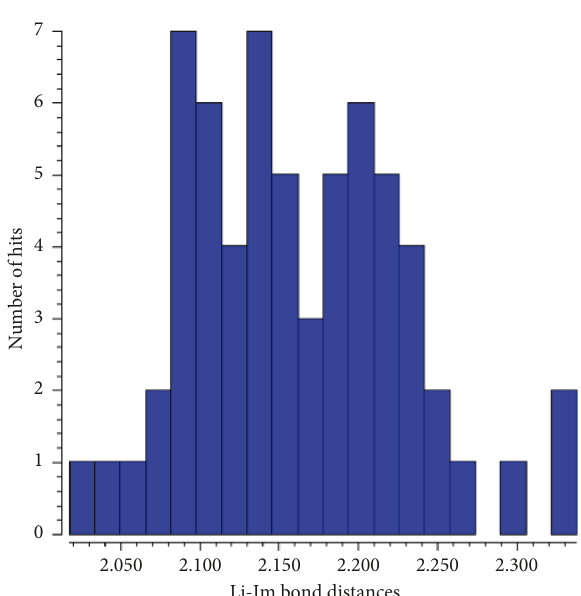
Figure 1: Distribution of the Li-Im bond lengths in the